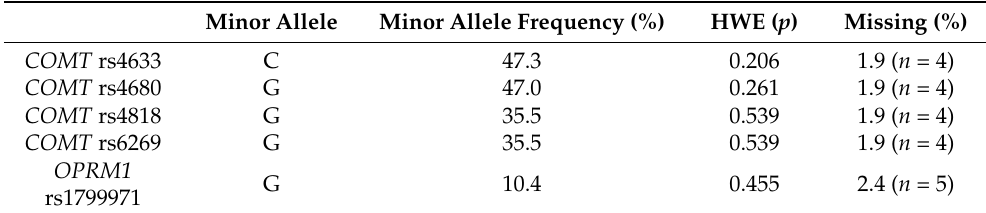
Table 2. Descriptive analysis of the catechol-O-methyltransferase ( COMT ) and µ -opioid receptor ( OPRM1 ) variants.